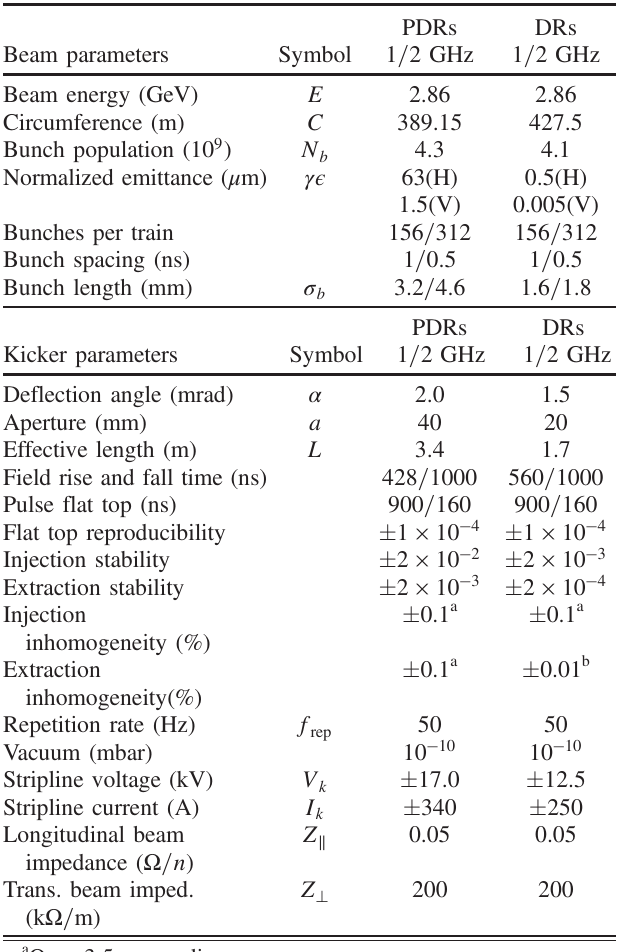
TABLE I. Beam parameters and kicker specifications for the PDRs and DRs for electrons